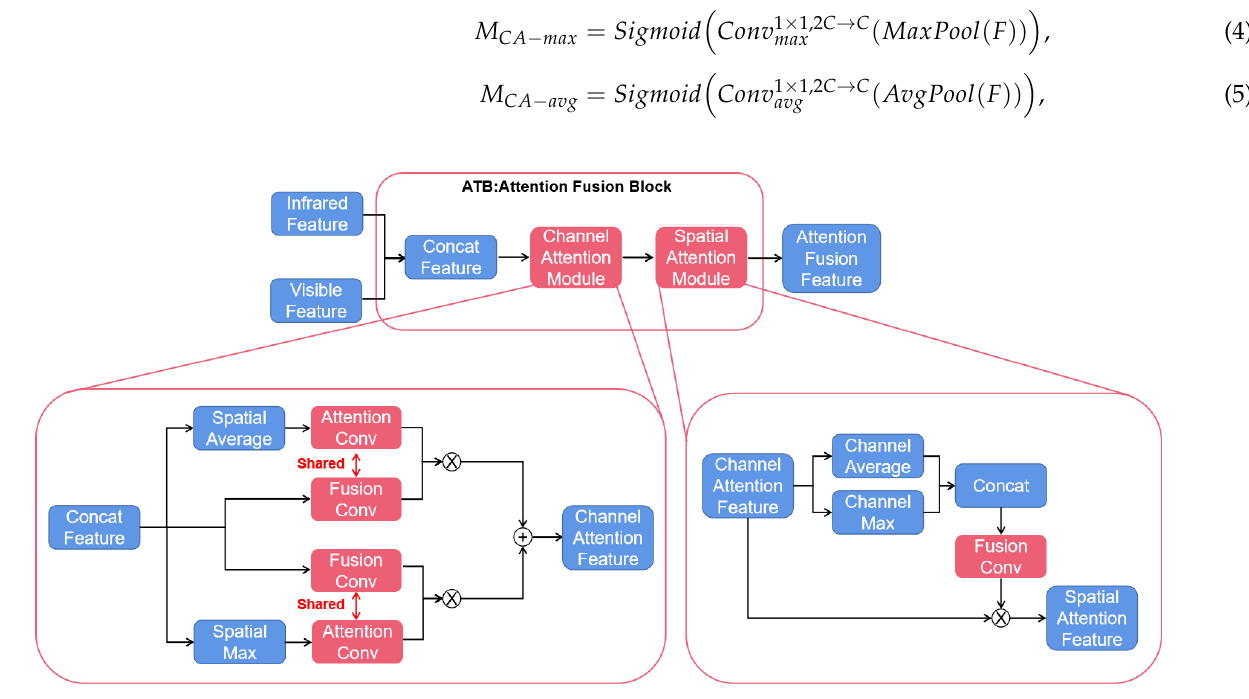
Figure 4. Main structure of the attention fusion block. Left part is the detailed structure of channel attention module and right part is that of spatial attention module.